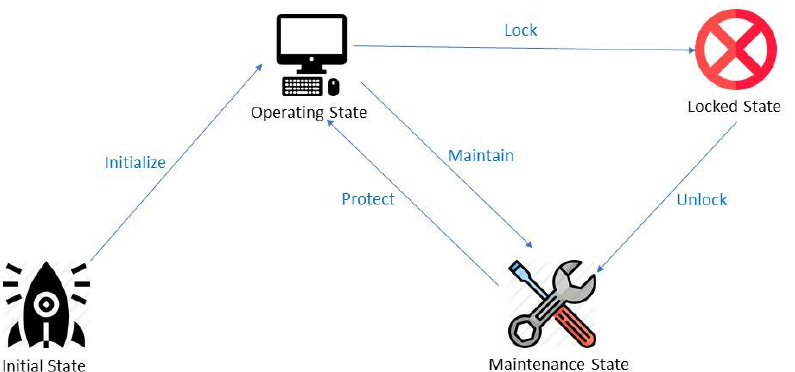
Figure 7. State diagram: There are four states in our system, including initial state, operating state, maintenance state, and locked state, and there are also five functions to change the four states, including initialize function, maintain function, lock function, unlock function, and protect function.